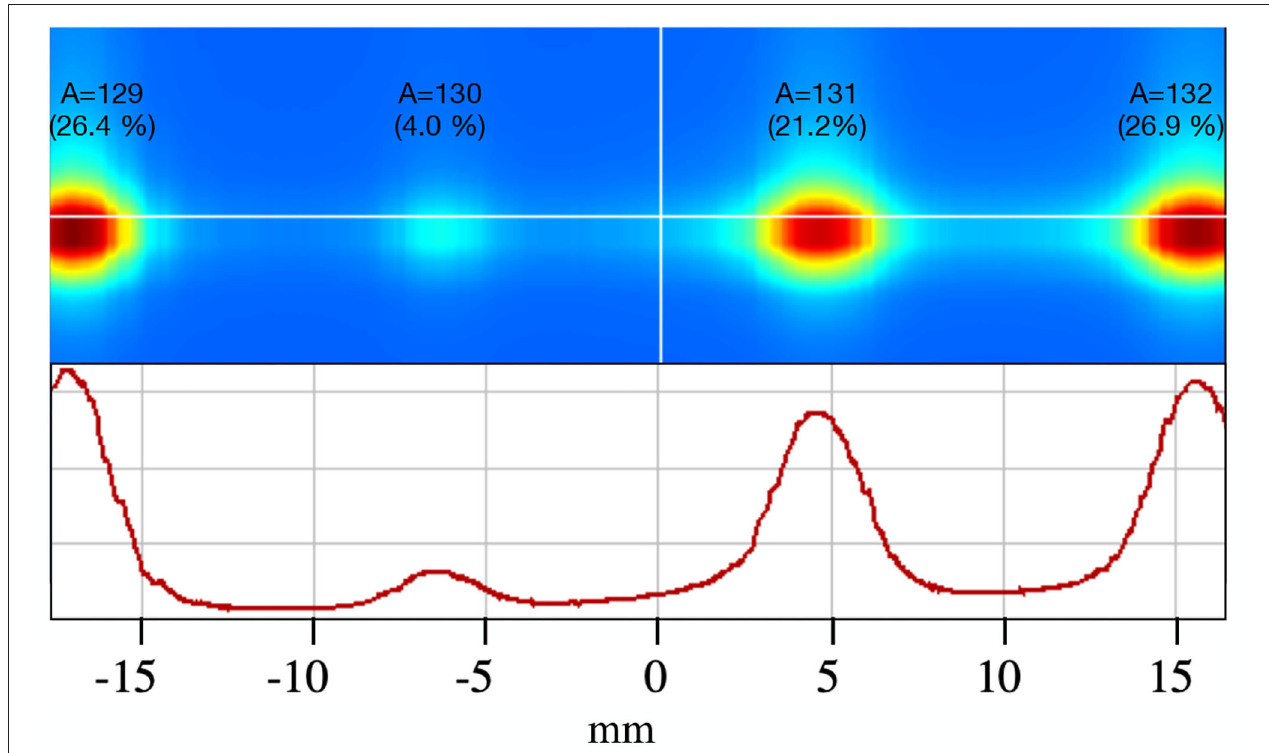
FIGURE 8 | Xe beam profile with A = 129, 130, 131, and 132 and respective natural abundances. The relative beam intensities and beam spotsize are represented via a heatmap (top) with red and blue being the maximum and minimum values, respectively. 2D plot of the Xe beam profile (bottom)